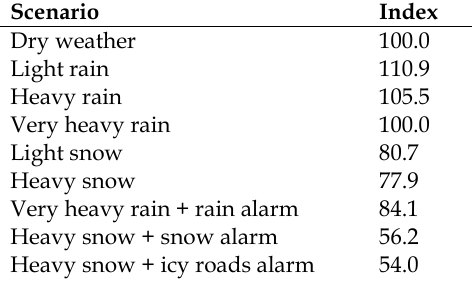
Table 5. Motorway morning peak traffic demand for different